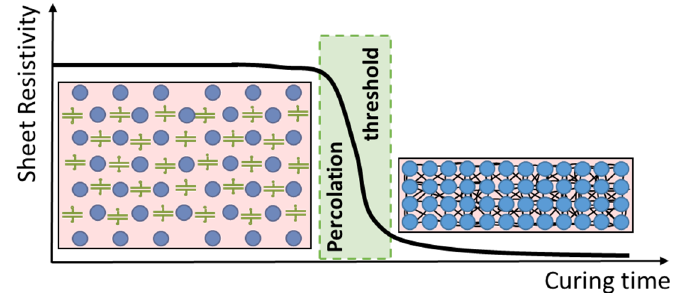
Figure 2. Curing process of particle based films.